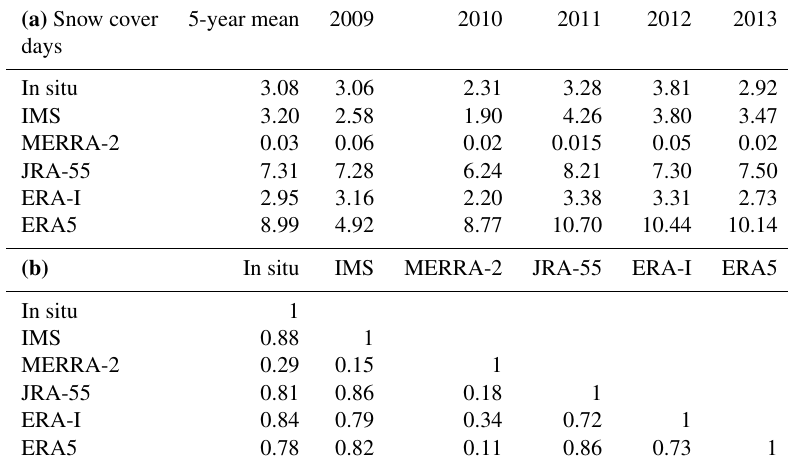
Table 3. Values of the annual means of monthly snow cover days averaged during the whole 5-year period (the second column) and during the years 2009 to 2013 (the third to seventh columns) for each dataset (a) . Temporal correlation matrix between in situ observations and reanalyses for monthly SCD during the whole 5-year period (b) . The SCDs are defined as the days when the SCF is greater than 0.5 and are averaged over the 33